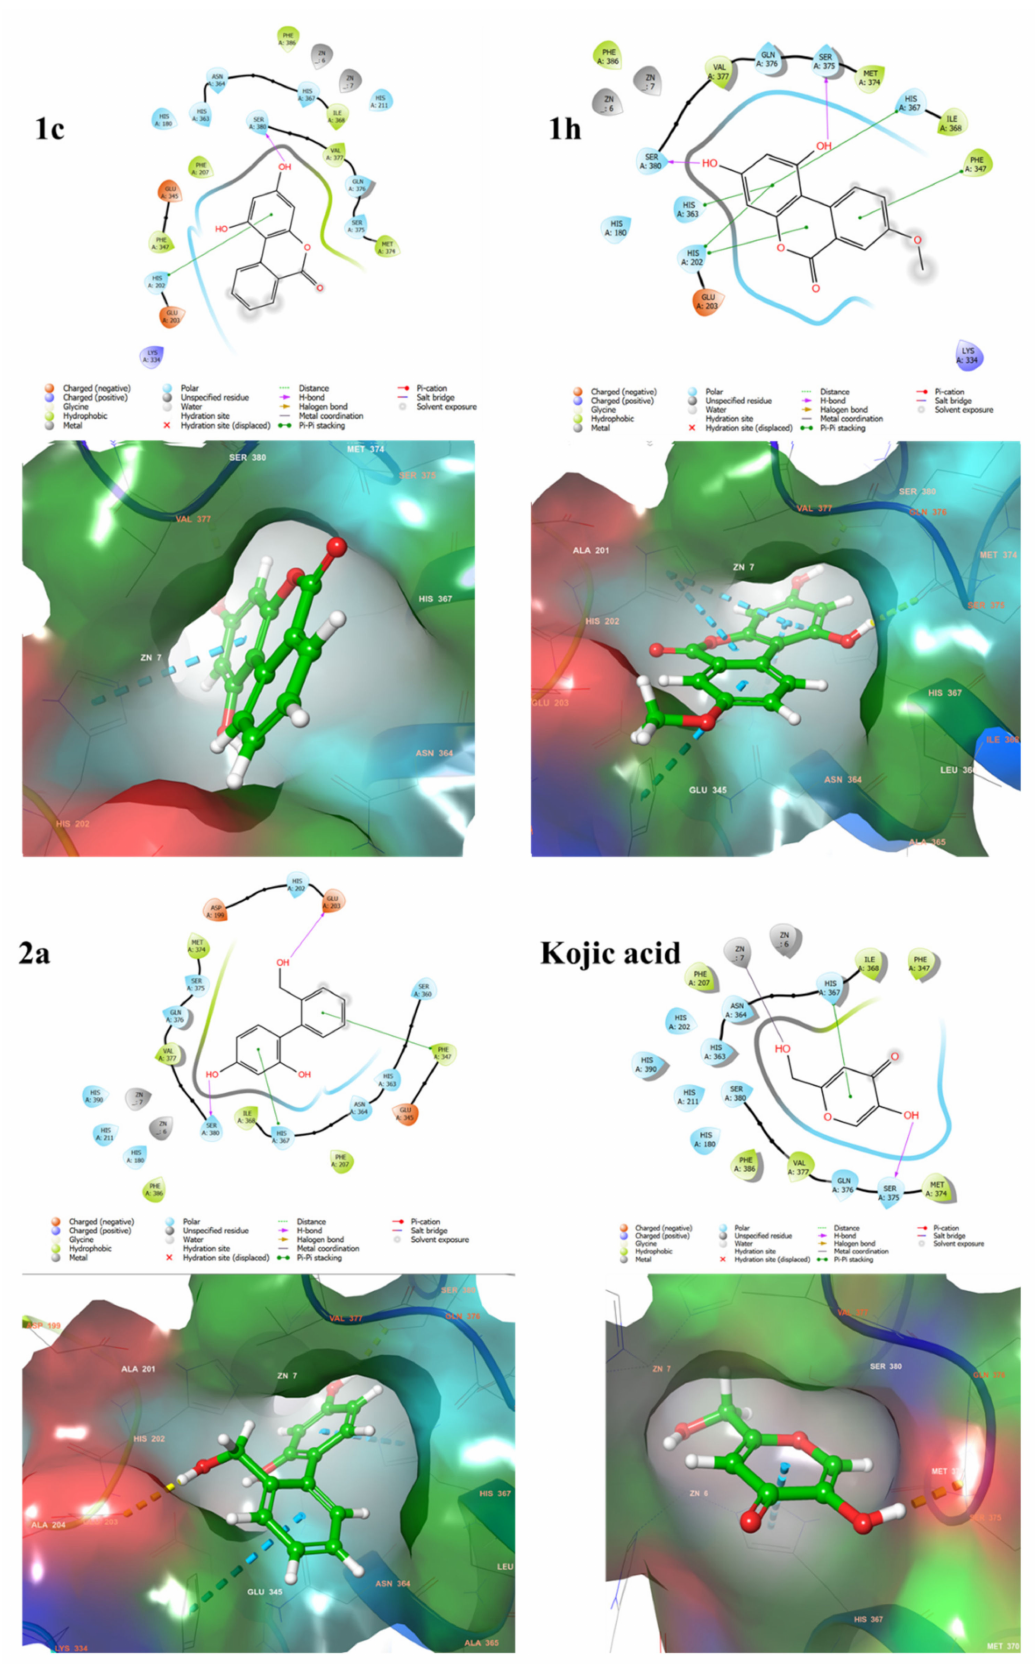
Figure 8. Predicted binding modes of 1c, 1h, 2a and kojic acid at the active site of a human tyrosinase homology model using Schrödinger Suite. Pharmacophore results are represented in 2D and 3D